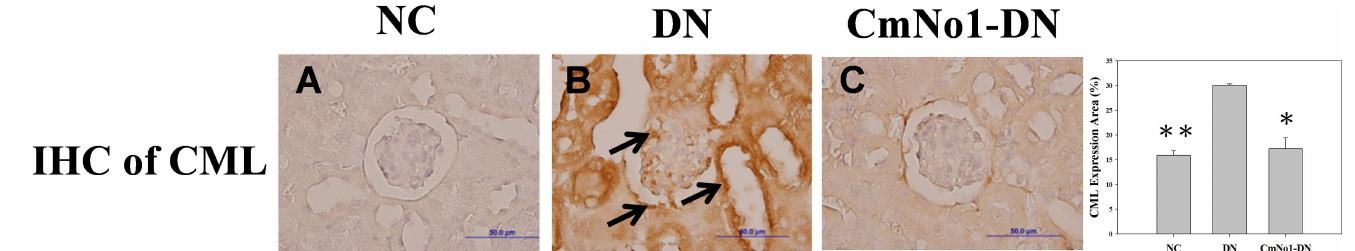
Fig 4. Efficacy of CmNo1 on carboxymethyl lysine (CML), an advanced glycation end product (AGE). immunohistochemialstaining of CML of kidney sections of NC, DN and CmNo1-DNgroup (A-C, ×